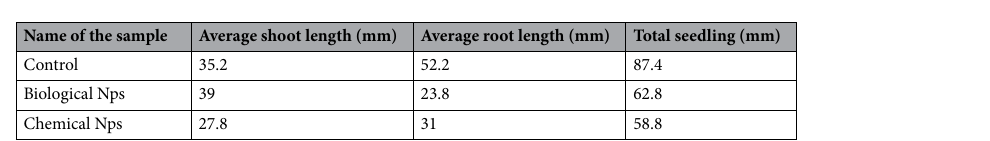
Table 2. Effect nano priming on seedling of the mung bean after 4 days.